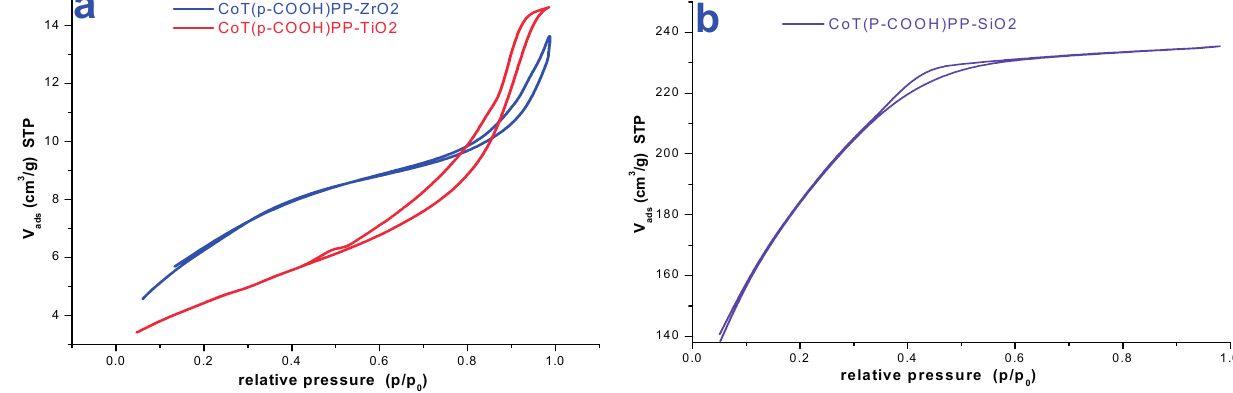
Figure 12. N2 sorption-desorption isotherms (at 76 K), measured after thermal treatment at 125 °C, on: ( a ) ZrO 2 and ( b ) TiO 2 xerogels containing the CoT( p- COOH)PP species bonded to the pore